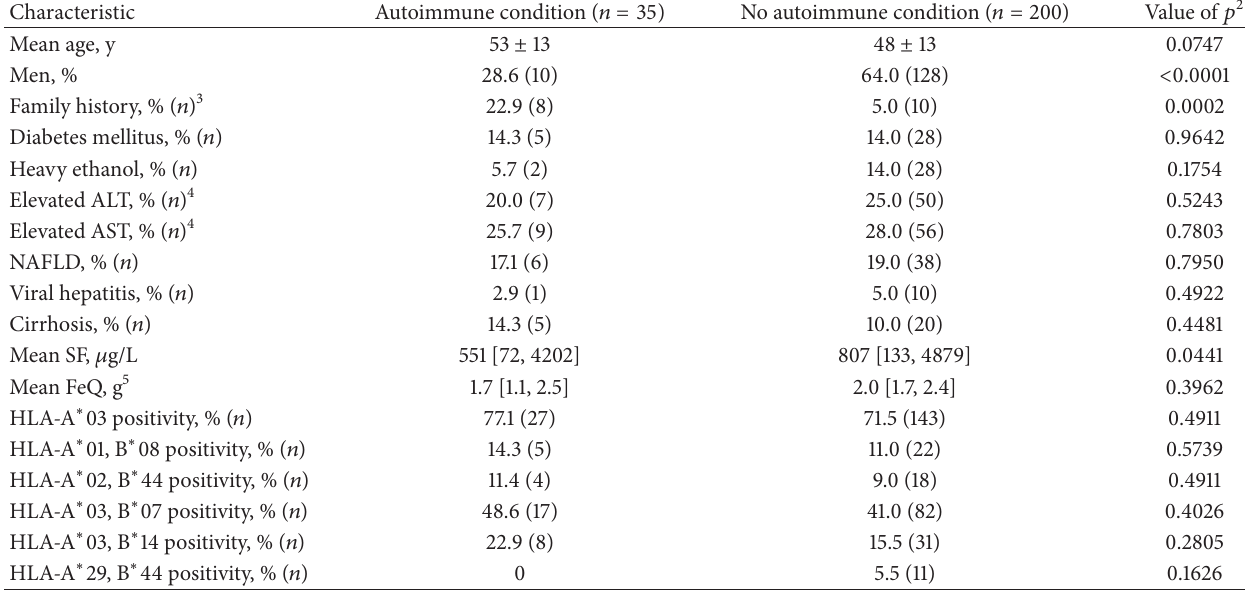
Table 1: Comparisons of hemochromatosis probands with and without autoimmune conditions 1 .